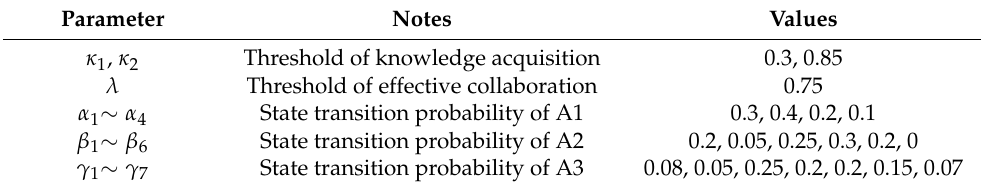
Table 2. Value of parameters in collaborative evolutionary model. Parameter Notes Values κ 1 , κ 2 Threshold of knowledge acquisition 0.3, 0.85 λ Threshold of effective